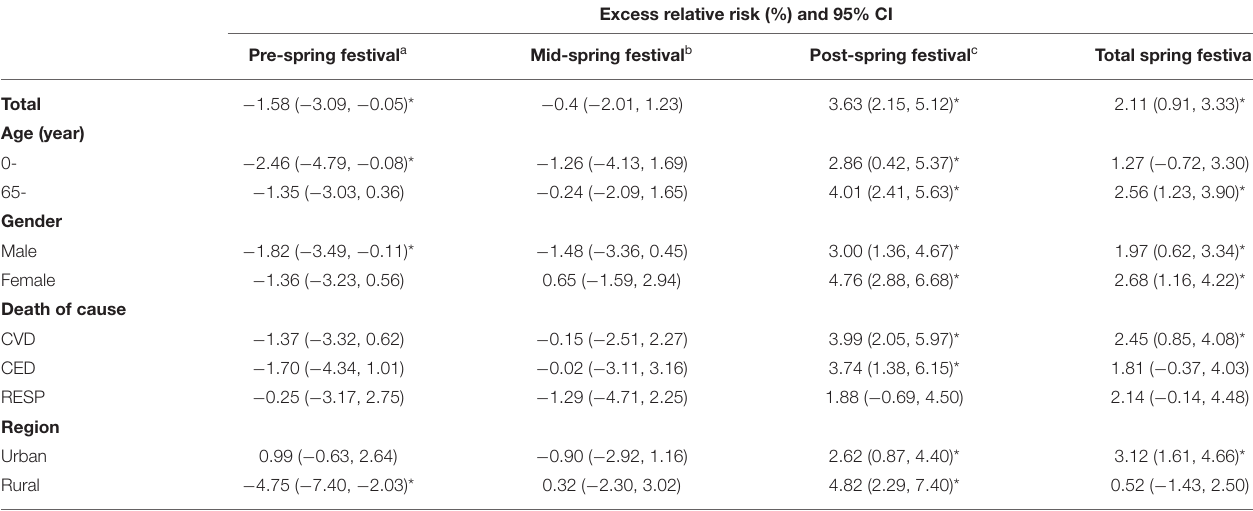
TABLE 2 | Excess relative risk (ERR, %) during the different phases of the Spring Festival period in China compared with control period.